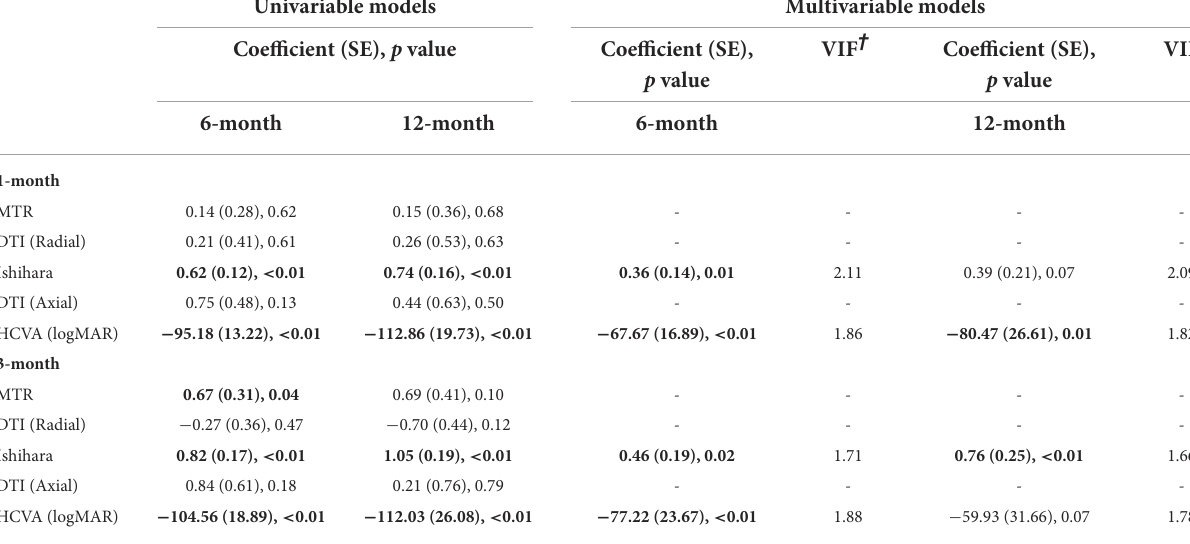
TABLE 2 LCLA 2.5%* asymmetry.